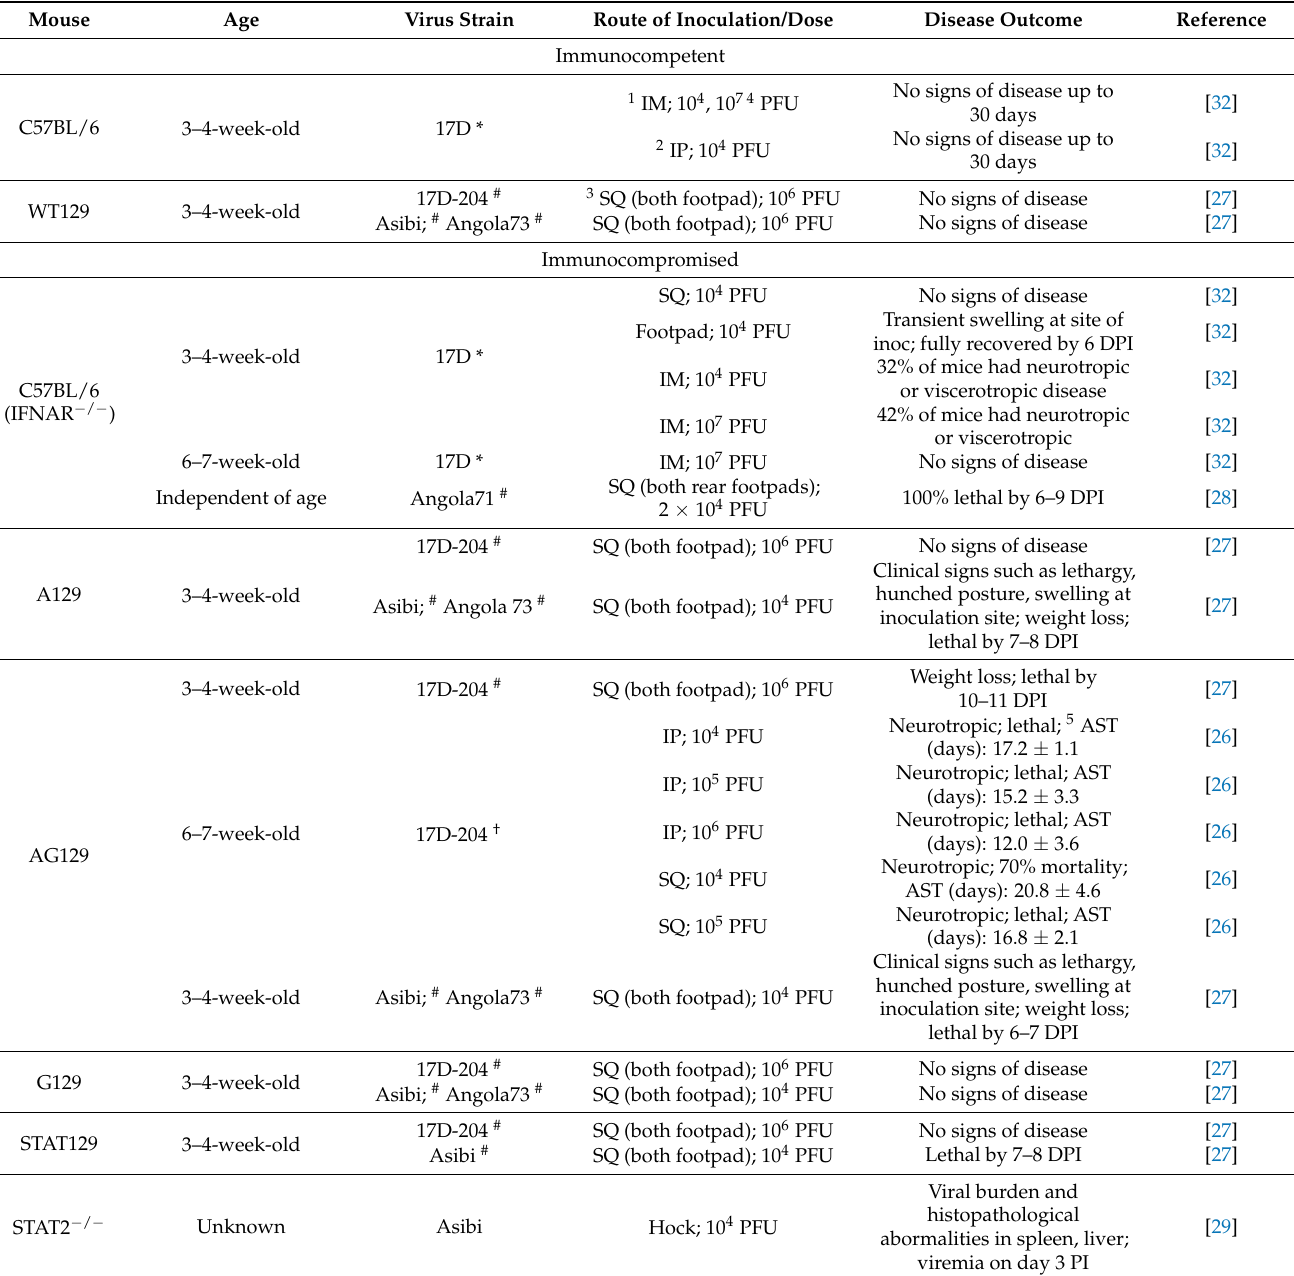
Table 1. Mouse models of YFV